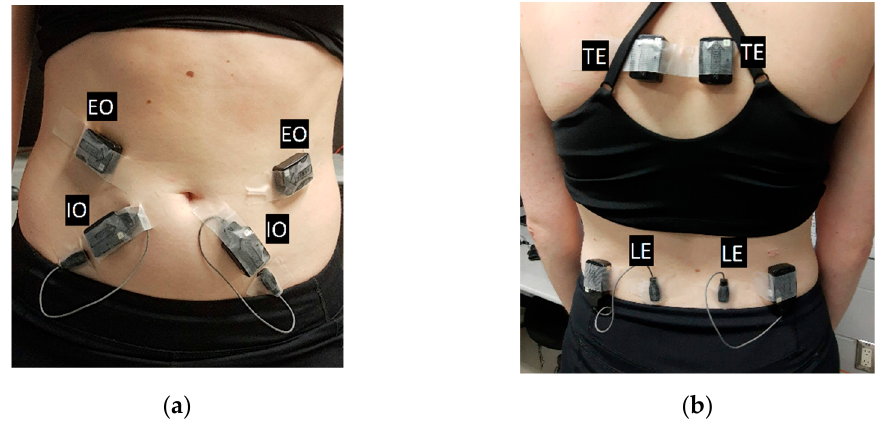
Figure 1. Bilateral EMG sensor placement for the ( a ) internal oblique (IO) and external oblique (EO) as well as the ( b ) lumbar erector spinae (LE) and thoracic erector spinae (TE).